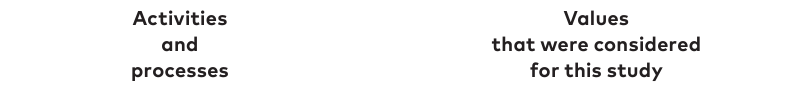
Table 4. Activities and processes that are